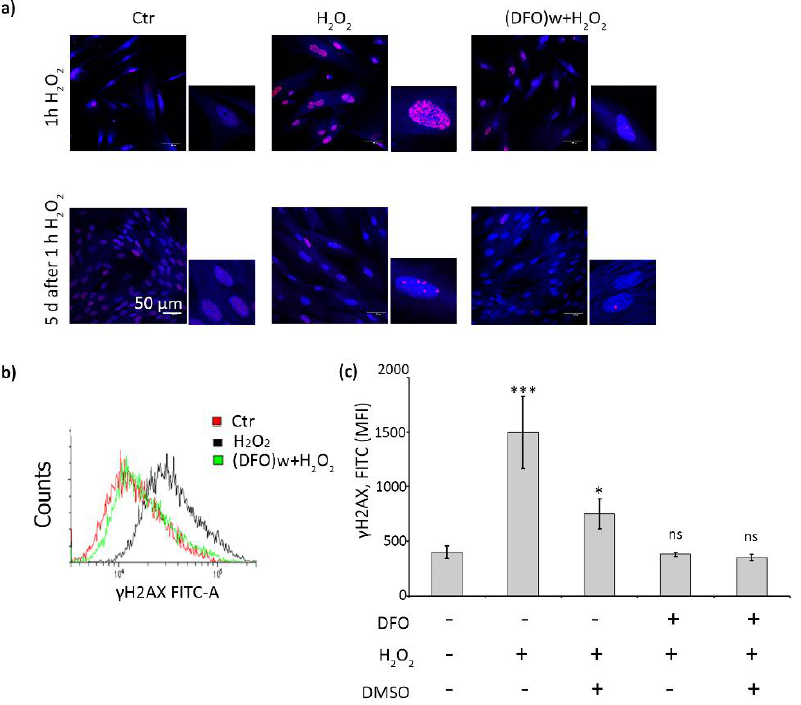
Figure 5. DFO prevents DNA damage and γH2AX foci formation in H 2 O 2 -stressed hMESCs. ( a ) Immunofluorescent analysis of γH2AX foci formation directly after stress execution and five days later; images are performed at 100× magnification, the scale bar is 50 µm, the enlarged insets are 50 × 50 µm; ( b ) representative histograms of the samples stained with γH2AX antibodies analyzed by FACS directly after stress execution; ( c ) to elucidate the role of hydroxyl radicals in DNA-oxidative damage of hMESCs DMSO was applied and γH2AX intensity was assessed by FACS. Data are shown as Mean ± SD, n = 3, * p ˂ 0.05, *** p ˂ 0.005.